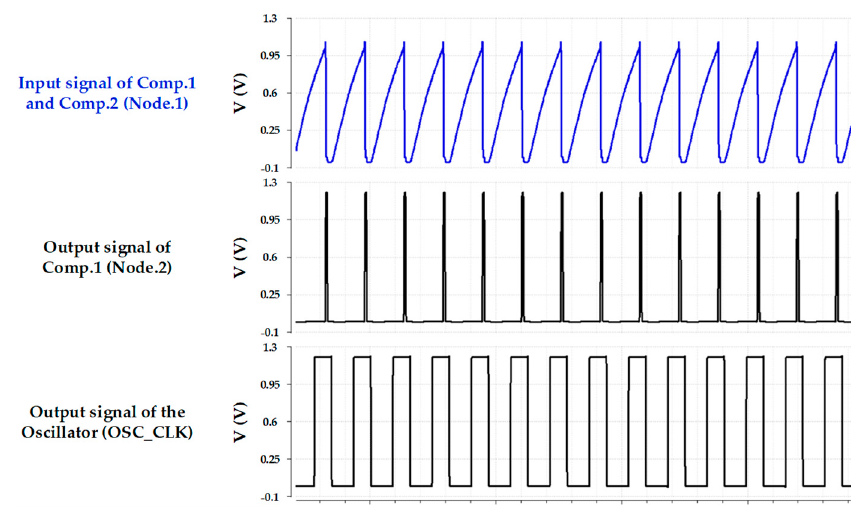
Figure 8. Simulated timing diagram of proposed relaxation oscillator.